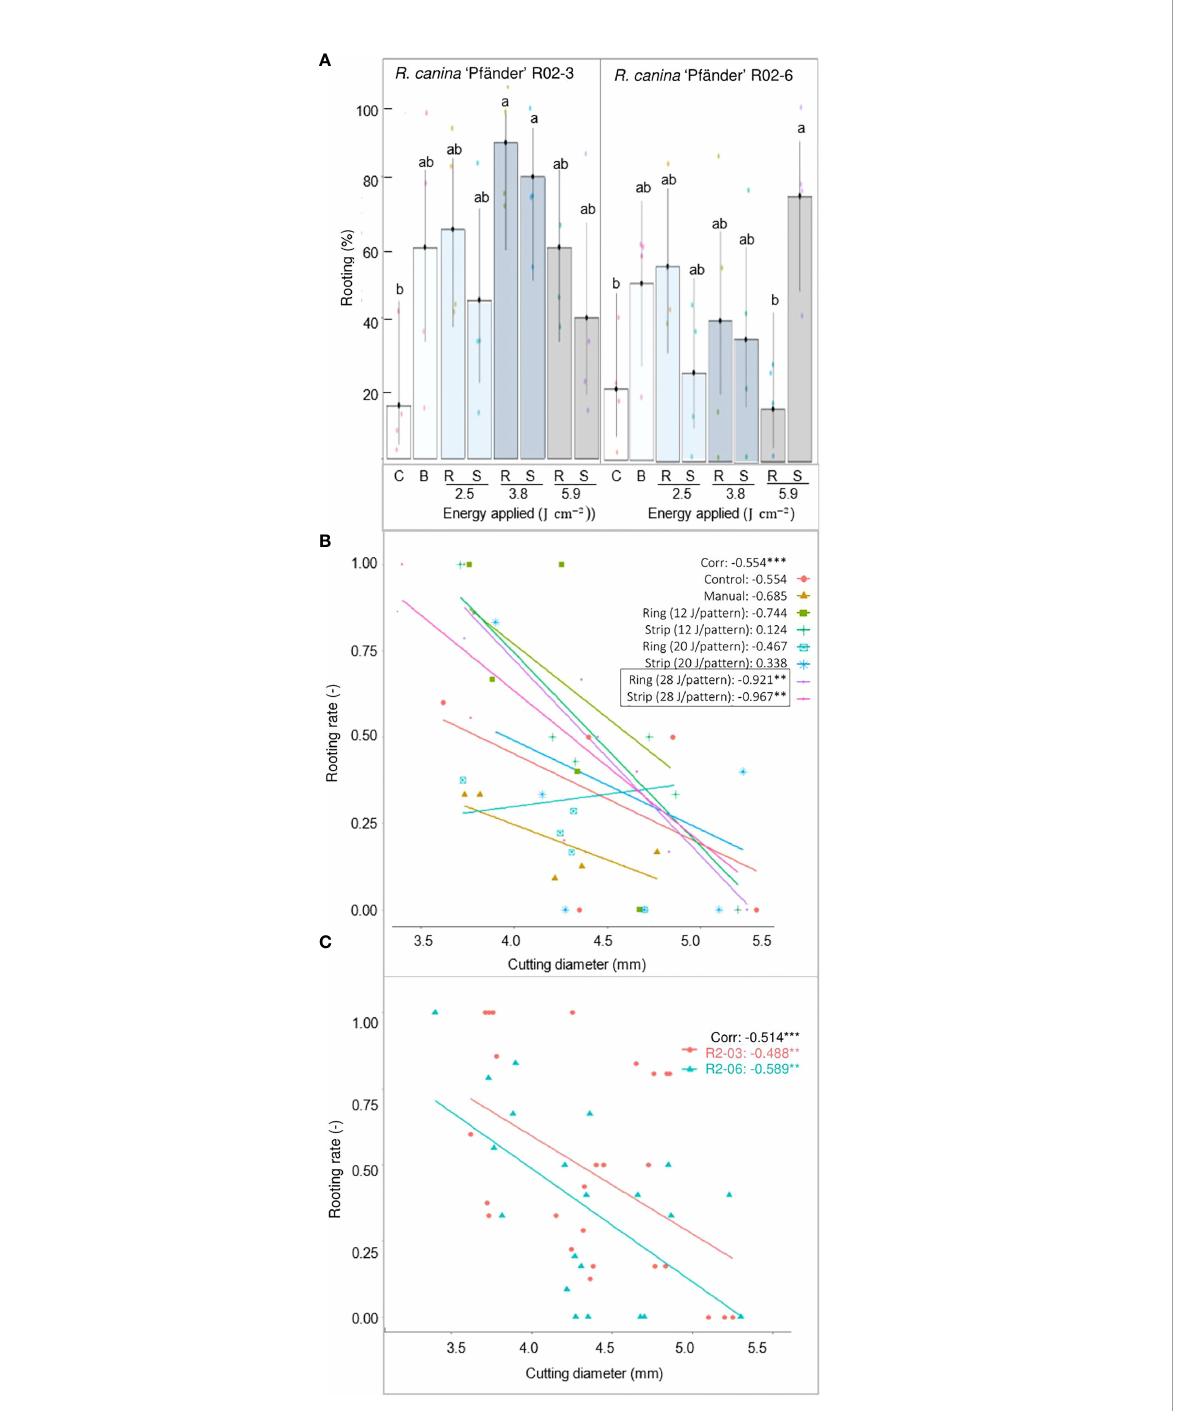
FIGURE 4 AR formation depending on the different wounding treatments of R. canina 'Pfänder' cuttings in presence of exogenous IBA (1 mg L- 1 ) after 4 week of culture. (A) Rooting percentage of R. canina 'Pfänder' R02-3 and R. canina 'Pfänder' R02-6 classi fi ed by the treatment (three laser intensities and two laser patterns): C- control treatment, B- blade (manual wounding) treatment, R- ring pattern, S- strip pattern. Columns represent the mean values with its con fi dence intervals (n=20). Columns that do not share a common letter represent signi fi cantly different levels (Tukey test, p ≤ 0.05). (B) Pearson`s correlation between rooting percentage and cutting diameter classi fi ed by treatment. (C) Pearson`s correlation between rooting percentage and cutting diameter classi fi ed by cultivar. **, *** Signi fi cant at P ≤ 0.01, 0.001,